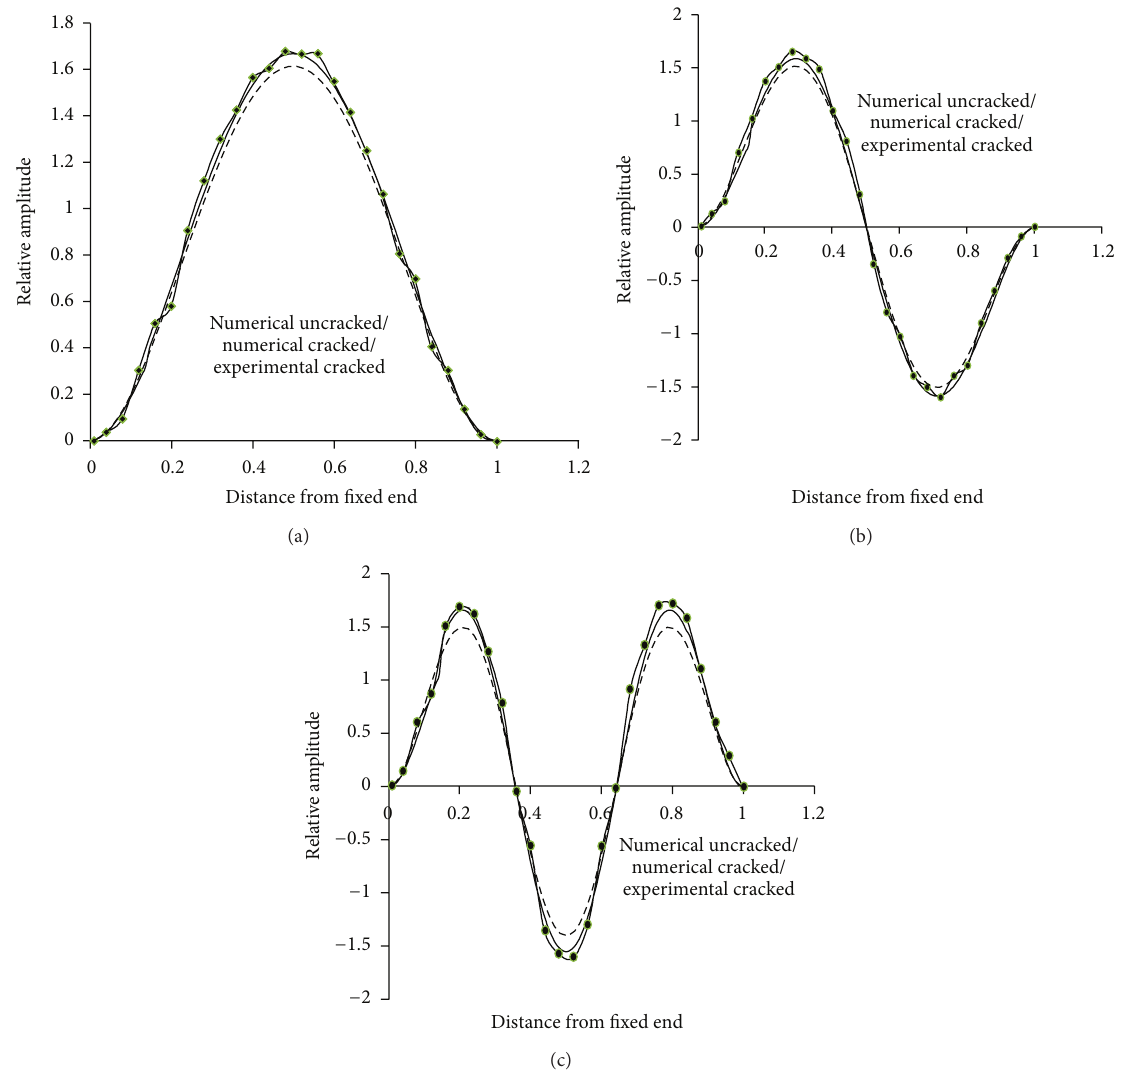
Figure 9: (a) Relative amplitude versus distance from the fixed end (1st mode of vibration) 𝐿 1 = 0.015 m, 𝐿 2 = 0.85 m, 𝑏 1 /𝐷 = 0.1 , and 𝑏 2 /𝐷 = 0.1 . (b) Relative amplitude versus distance from the fixed end (2nd mode of vibration) 𝐿 1 = 0.015 m, 𝐿 2 = 0.85 m, 𝑏 1 /𝐷 = 0.1 , and 𝑏 2 /𝐻 = 0.1 . (c) Relative amplitude versus distance from the fixed end (3rd mode of vibration) 𝐿 1 = 0.015 m, 𝐿 2 = 0.85 m, 𝑏 1 /𝐷 = 0.1 , and 𝑏 2 /𝐷 = 0.1